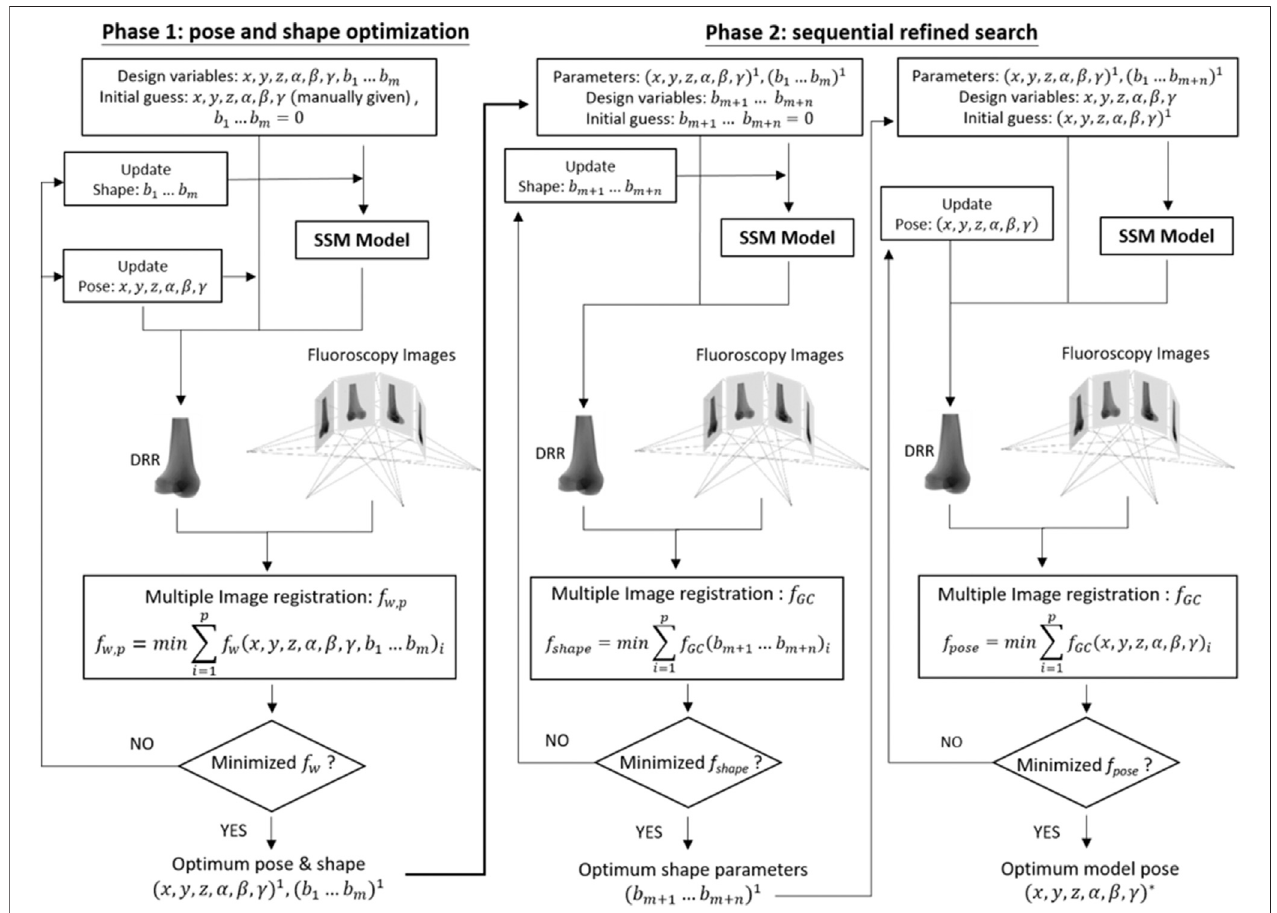
FIGURE 2 | Two-phase optimization scheme for reconstructing a personalized statistical shape model of the knee. In the current study, m (cid:2) 10 and n (cid:2) 10 were taken.